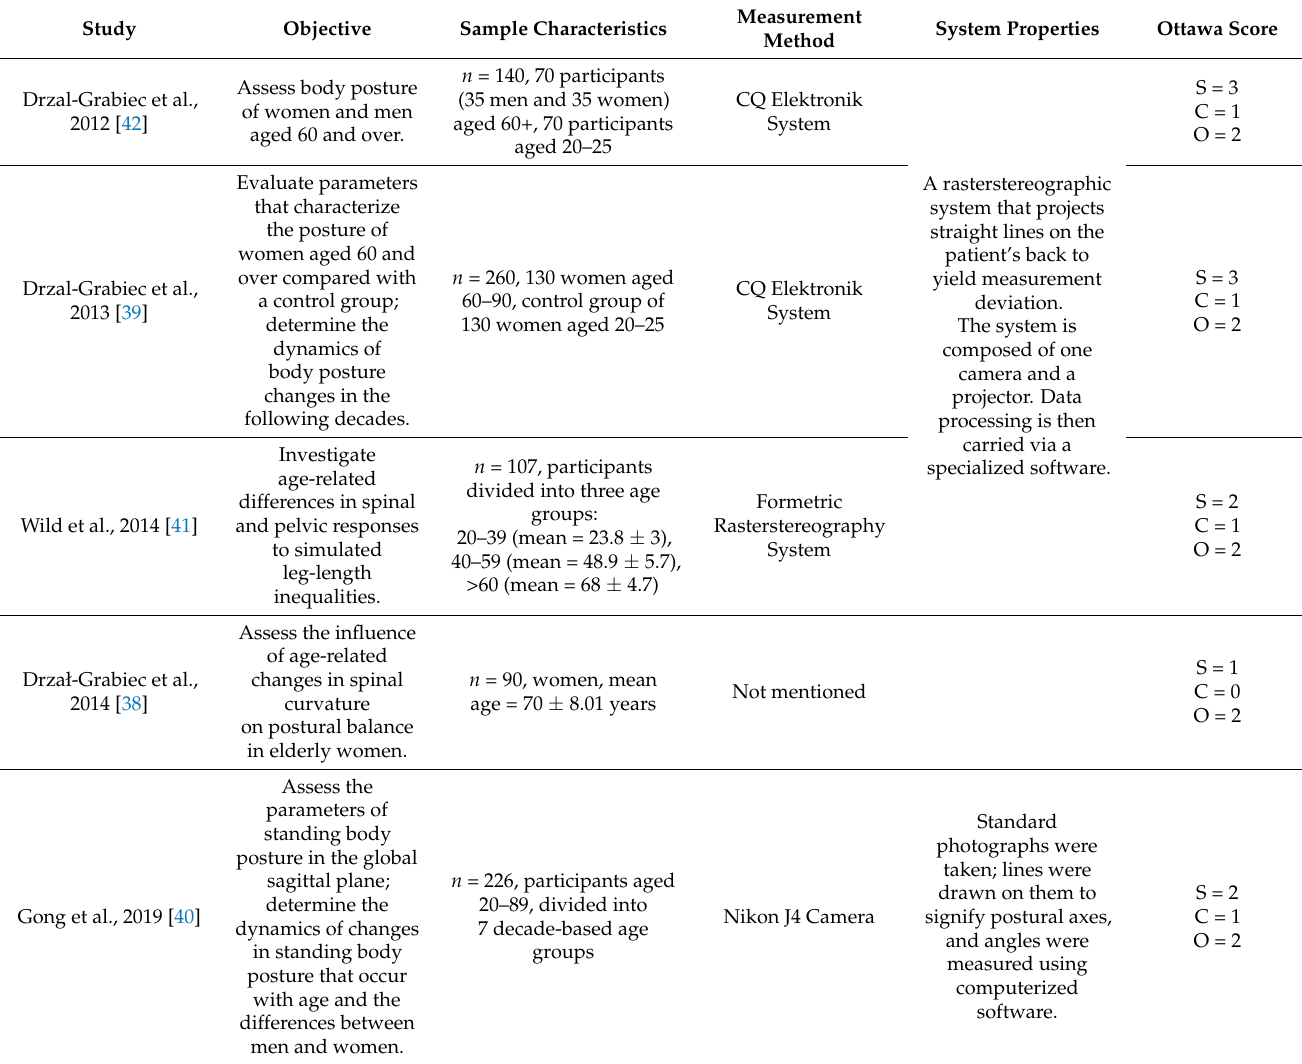
Table 1. Main characteristics of included